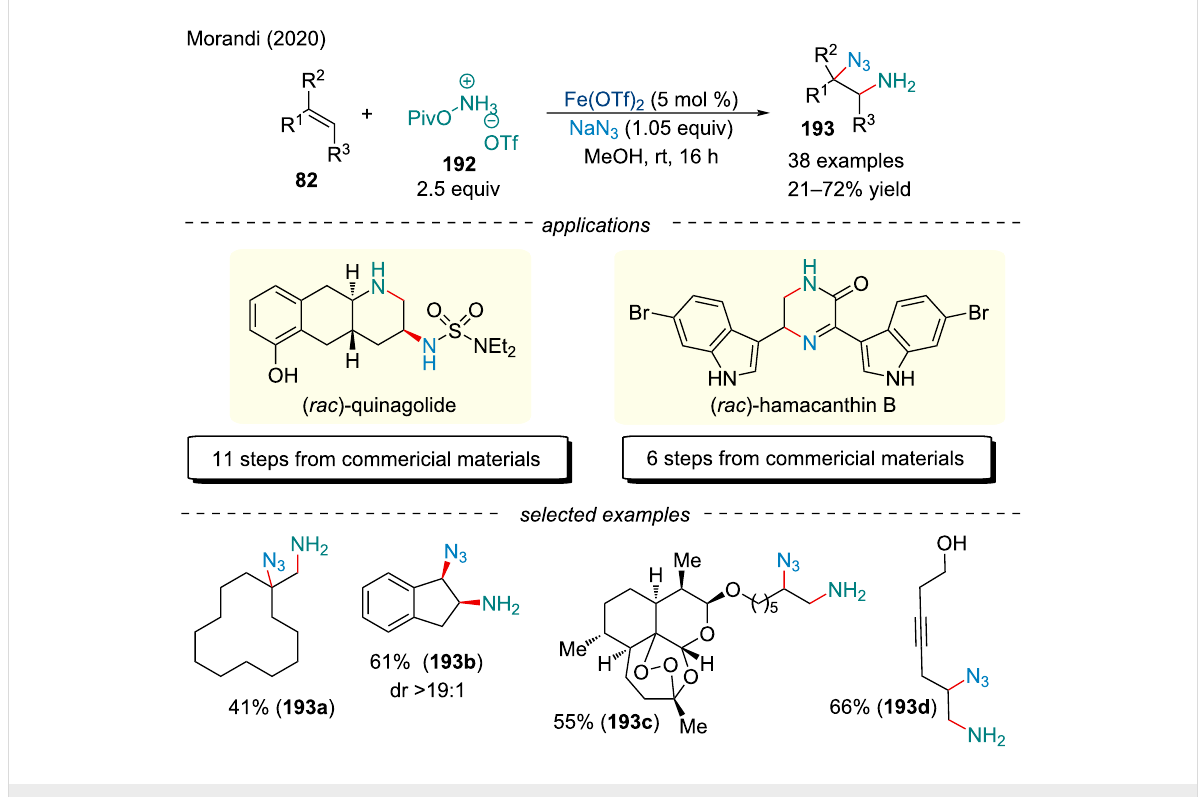
Scheme 44: Iron-catalyzed three-component aminoazidation of alkenes 82 .